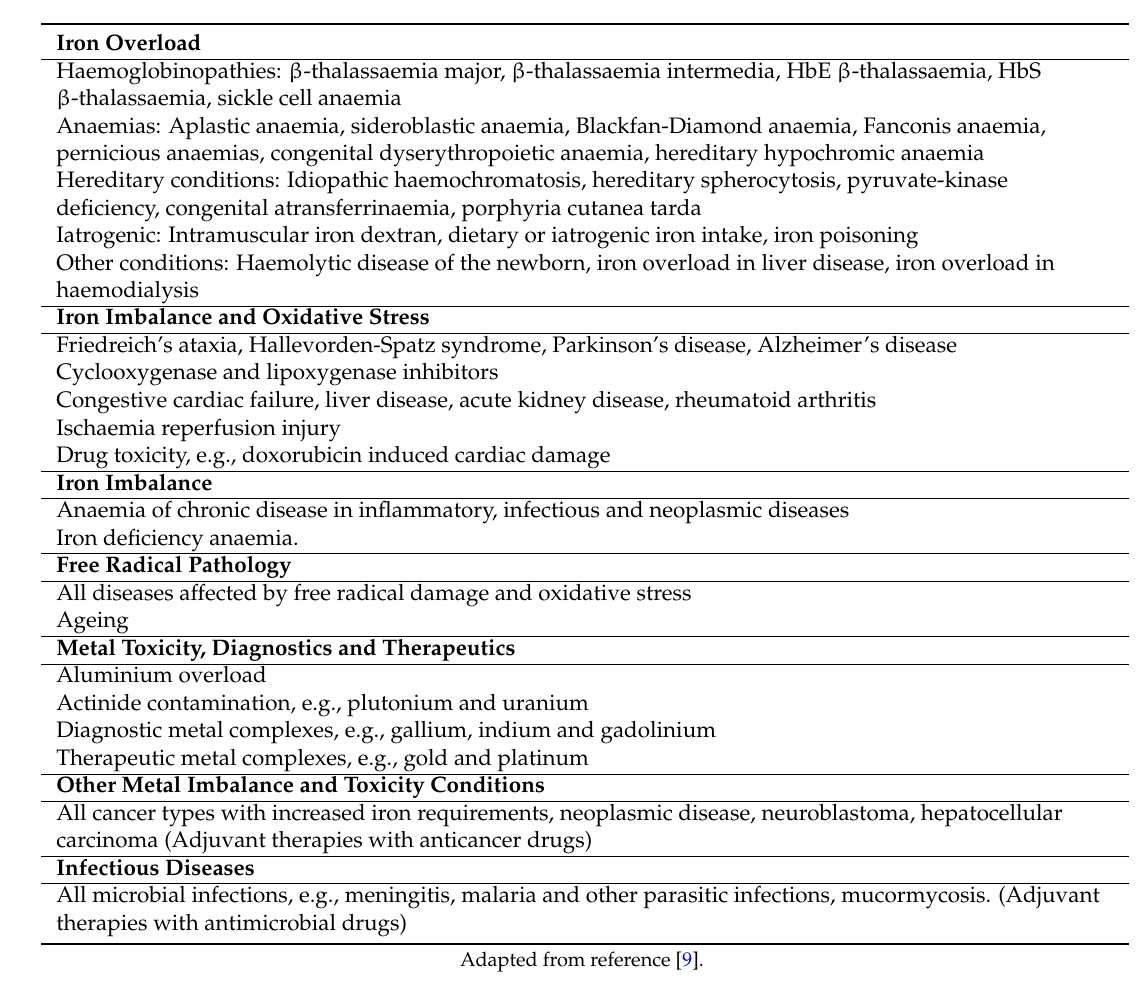
Prospects of targeting therapies of iron phytochelators in iron overload and other clinical